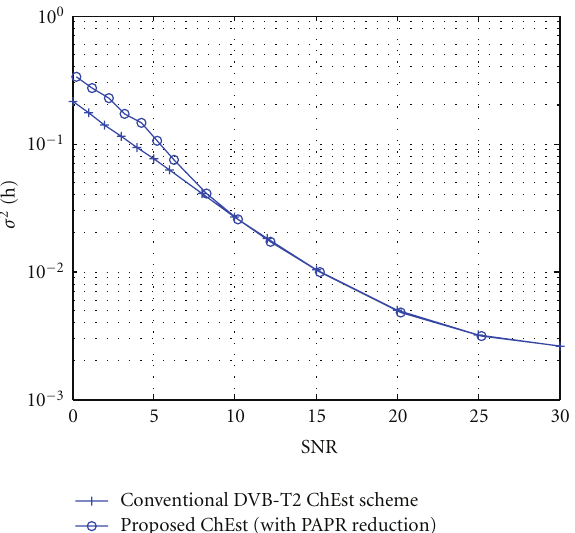
Figure 19: BER performance, 2 K mode, 16-QAM modulation, and F1 channel.